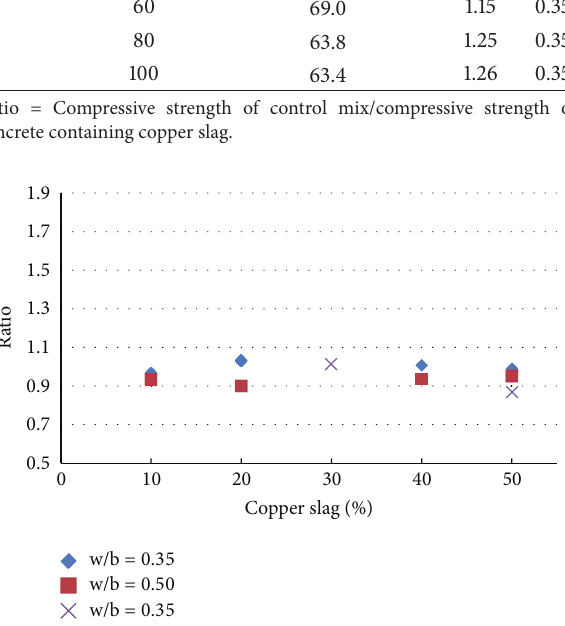
Figure 12: Plot of experimental results from [10, 16, 17].